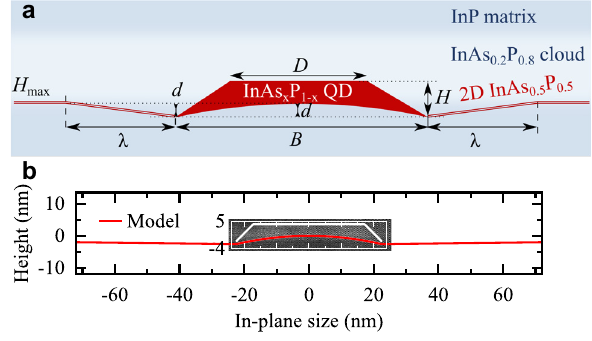
Figure 3: Scheme of a QD geometry. (a) Model of a QD and surrounding pit inferred from the STEM scans. (b) The modeled profile of the bottom base of the QD and the 2D InP(As) layer surrounding it (red line) overlaid on the STEM image in Figure 2a. The white eye-guiding line indicates the QD top